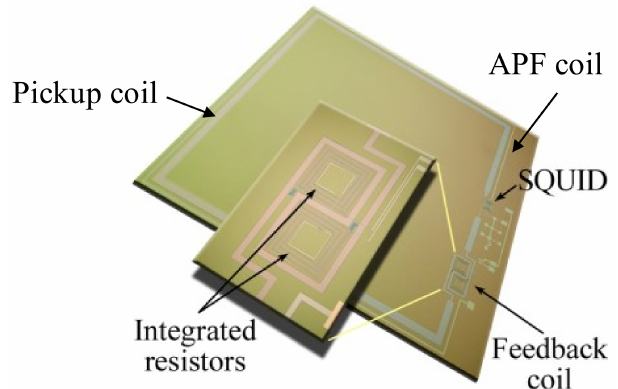
Figure 1. Picture of the fully integrated SQUID magnetometer. The enlarged detail shows the integrated feedback coil consists of two coils wrapped in opposite directions to reduce the crosstalk between neighboring channels and the heating